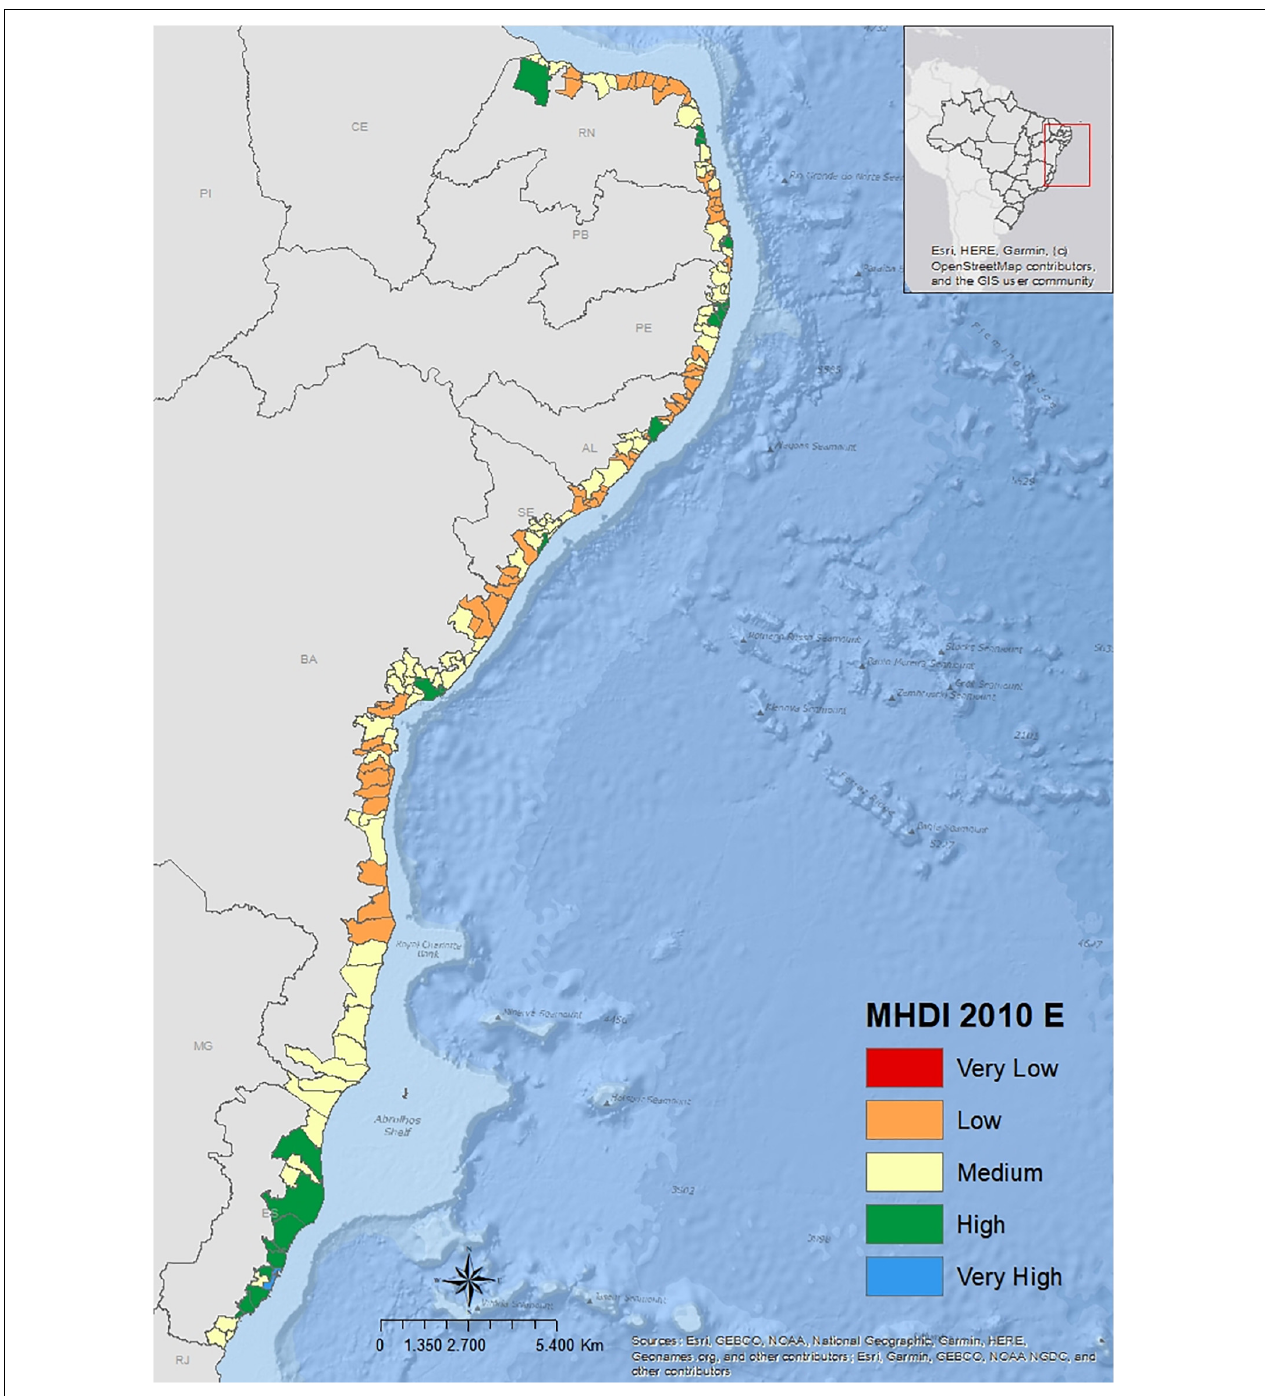
FIGURE 3 | MDHI for the East coast municipalities. Elaborated by the authors with data from PNUD et al. (2020).